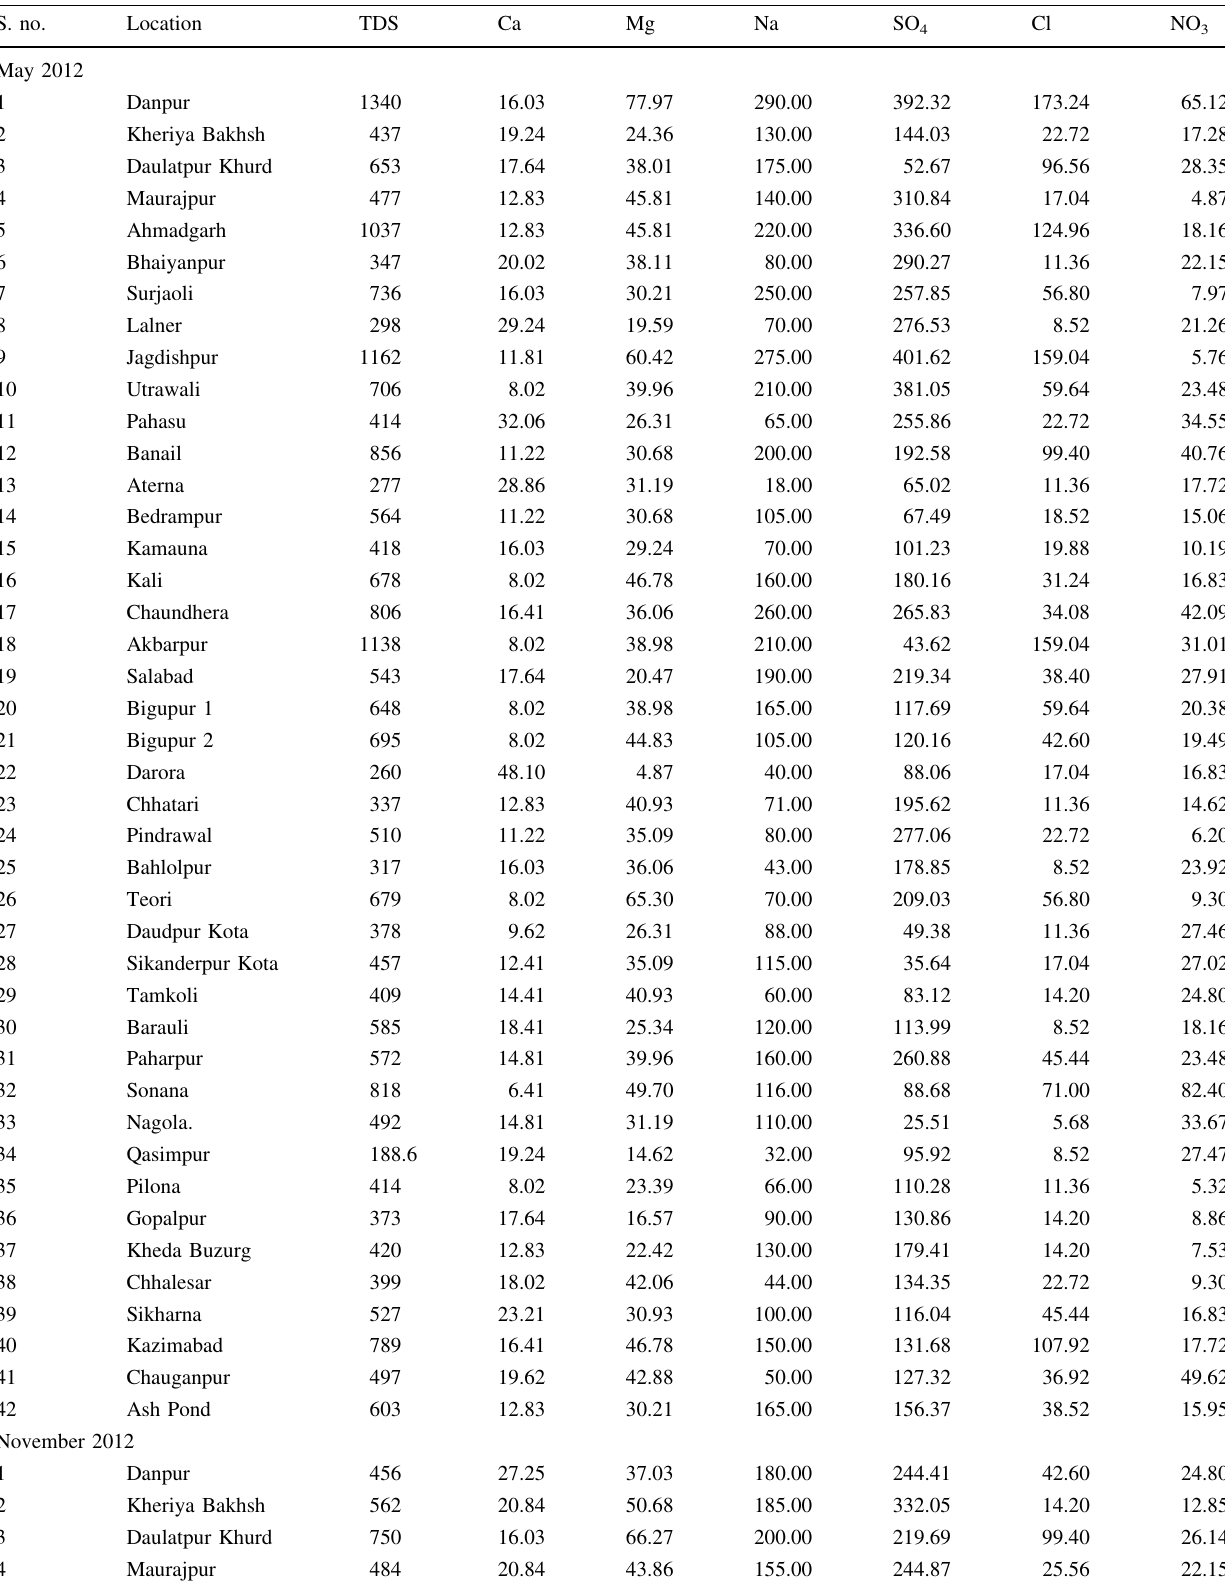
Table 1 Groundwater quality data (parameters selected for GQI mapping) in mg/l S.